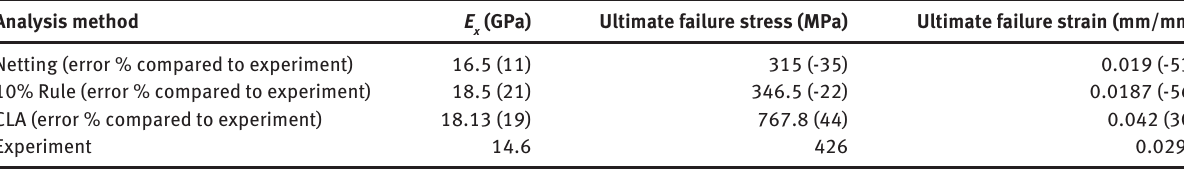
, 0 ] specimen tensile results. 4 4 s